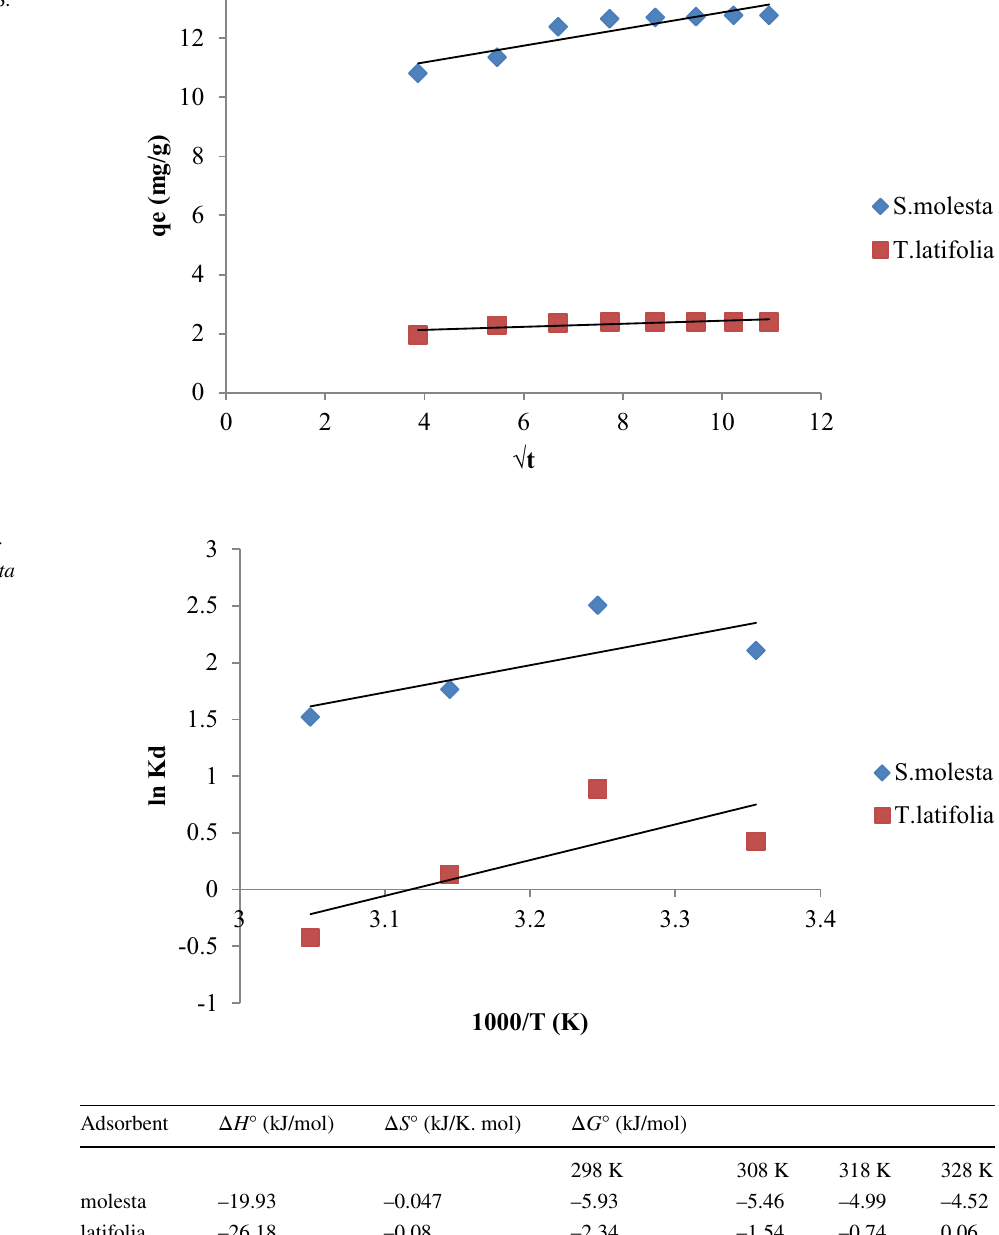
Table 3. The negative value of enthalpy change (ΔH°) signi- fies that the process is an exothermic type and the amount of adsorption involves the formation of certain chemical processes that are present throughout the adsorption pro- cess (Kumar et al. 2013). The negative value of free energy change (Δ G °) proves that the adsorption process is spon- taneous and feasible at a given temperature. The decreas- ing value of ΔG° with increase in temperature depicts that the degree of feasibility decreases for Cr 6+ adsorption. The negative value of ΔH° and ΔS° indicates that the process Fig. 15 Intraparticle diffusion plot for Cr 6+ adsorption on S. molesta and T. Latifolia